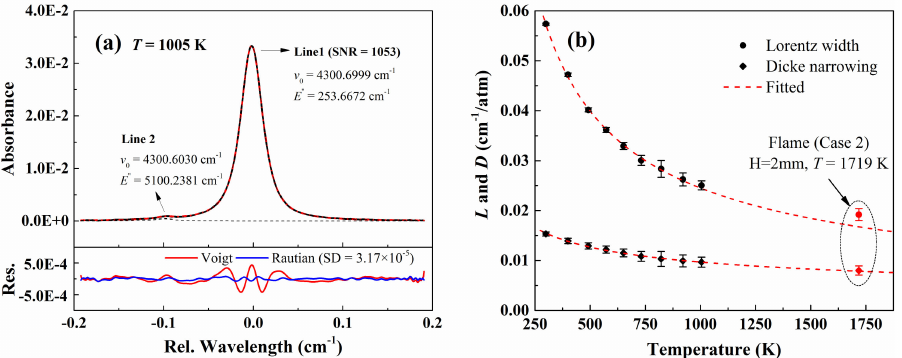
Figure 10. ( a ) Measured absorbance at a high temperature of 1005 K ( P = 40.95 kPa, L = 14.7 cm). ( b ) Measured collisional width and Dicke narrowing and their corresponding best-fit power-law, for example, L ( T ) = L ( T 0 )*( T 0 / T ) n , used to determine temperature exponents n